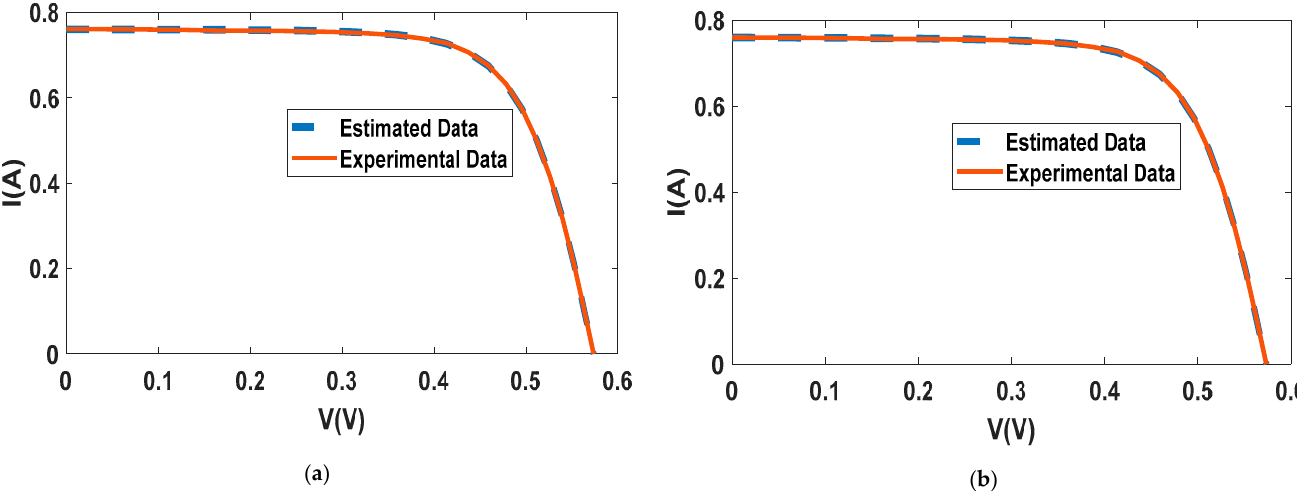
Table 8. Comparison of simulation results of EHO with corresponding results in the literature.